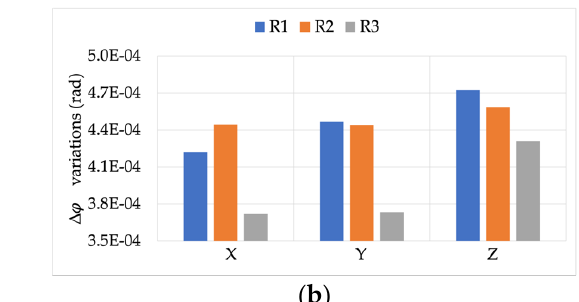
Figure 10. THD variations, compared to position L, obtained from measurements at the position N.